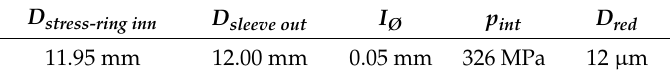
Table 1. Dimensional specifications of the pre-stressed tool.